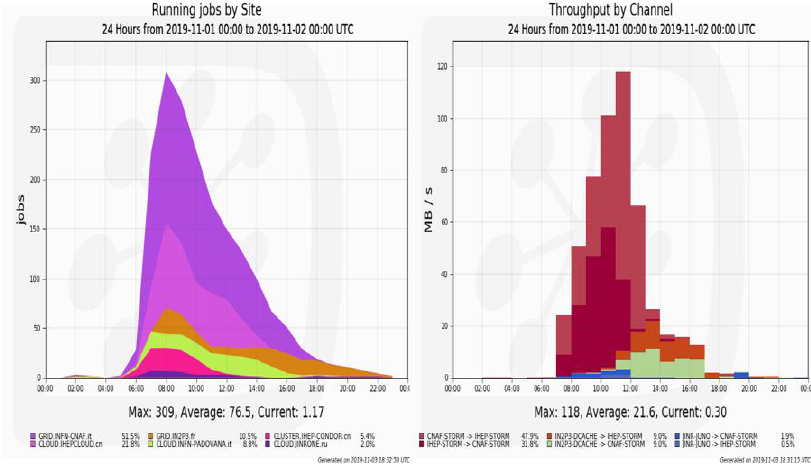
Fig. 7. Tests done for JUNO production system. The left plot shows the jobs running in sites and the right plot shows the replication speed between